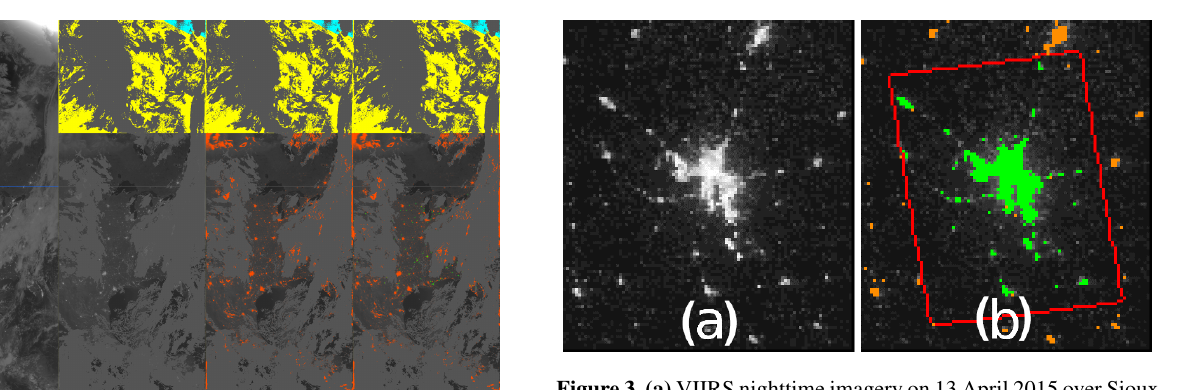
Figure 3. (a) VIIRS nighttime imagery on 13 April 2015 over Sioux City, Iowa, US. Panel (b) is similar to (a) but shows detected artifi- cial light sources using data within ± 0 . 28 ◦ (latitude) and ± 0 . 295 ◦ (longitude) of the city center (green), as indicated by the red box. Orange colors show the detected artificial light sources through a granule-level detection. Only green pixels are utilized for aerosol